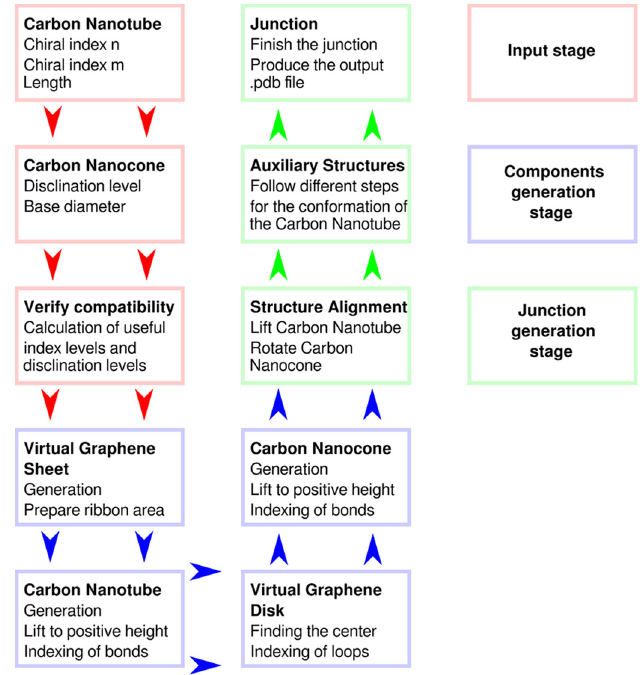
Figure 2. Flowchart of the detailed steps of the algorithm.